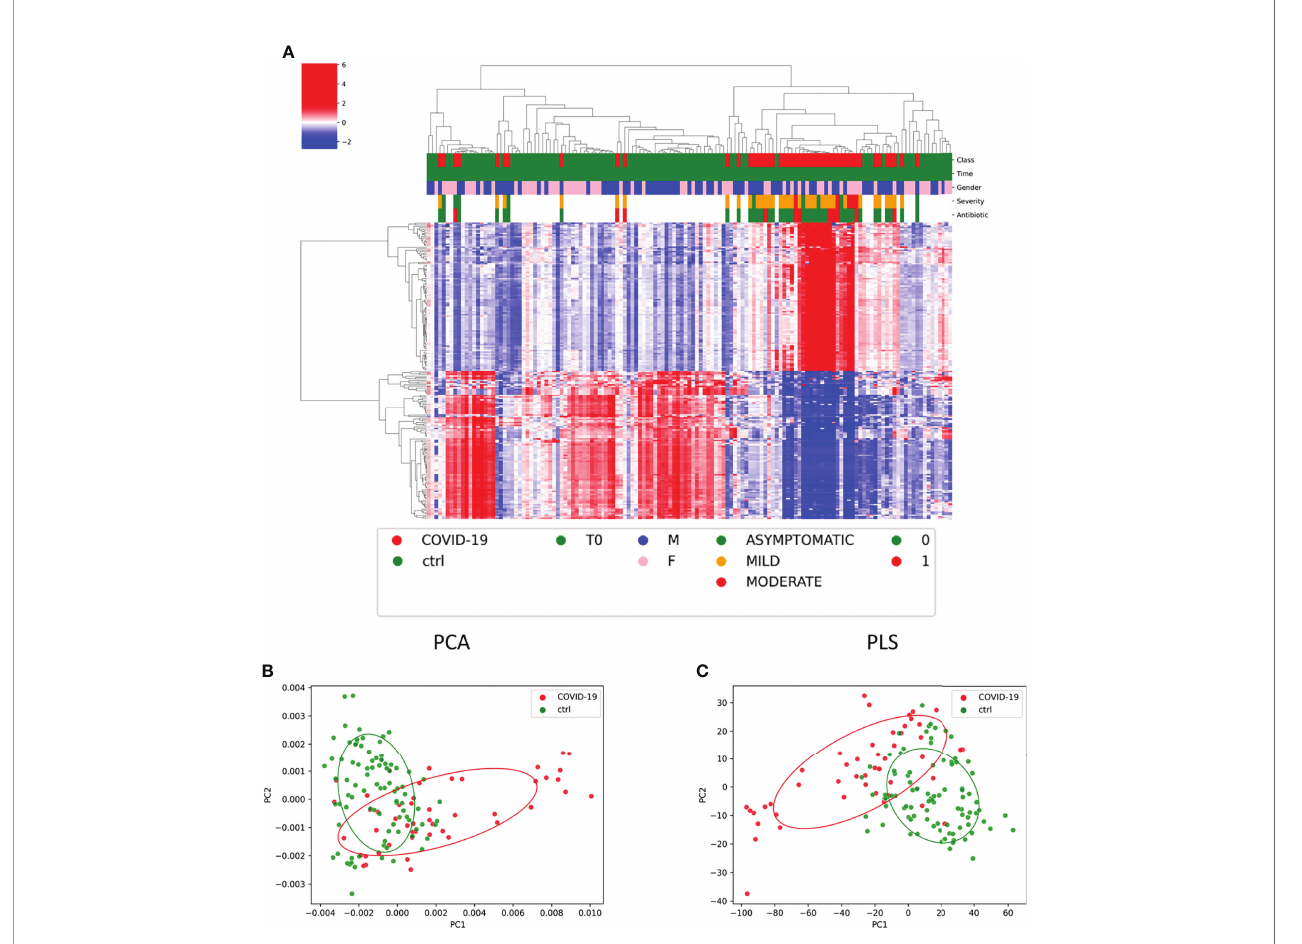
FIGURE 7 | Functional pro fi le of microbial communities of COVID-19 and CTRL subgroups. (A) Graphical representation of hierarchical analysis of the KO-based prediction of functional pro fi le of microbial communities of COVID-19 and CTRL subgroups. The top 200 features with lowest p -value (p < 0.05). The color scale characterizes the Z- score for each variable: red, high level; blue, low level. The column color labels represent respectively: patient ’ s class (red, COVID-19; green, CTRLs), time (green, T 0 ), gender (blue, male; pink, female), severity (green, asymptomatic; orange, mild; red, moderate), and antibiotic [green, absent (0); red, present (1)]. (B, C) Principal component analysis (PCA) and partial least-squares regression (PLS) interpretable visualizations, based on of KO feature projection for COVID-19 and